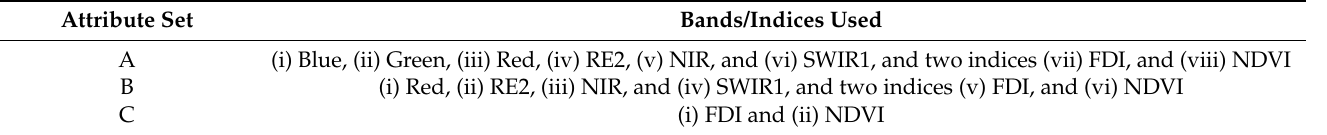
Table 3. Details of attribute sets used for